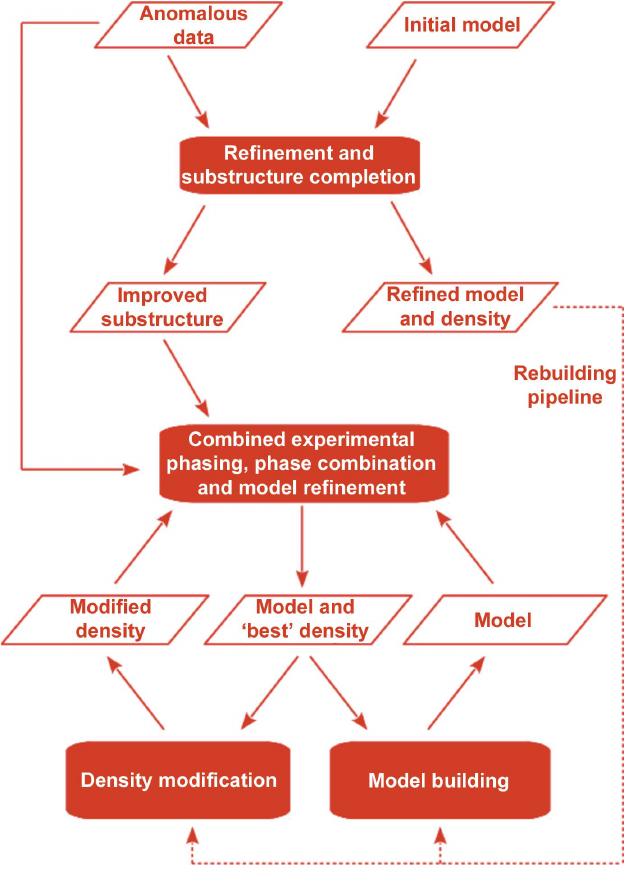
Figure 1 Flow chart for the ‘substructure-only’ and ‘rebuilding’